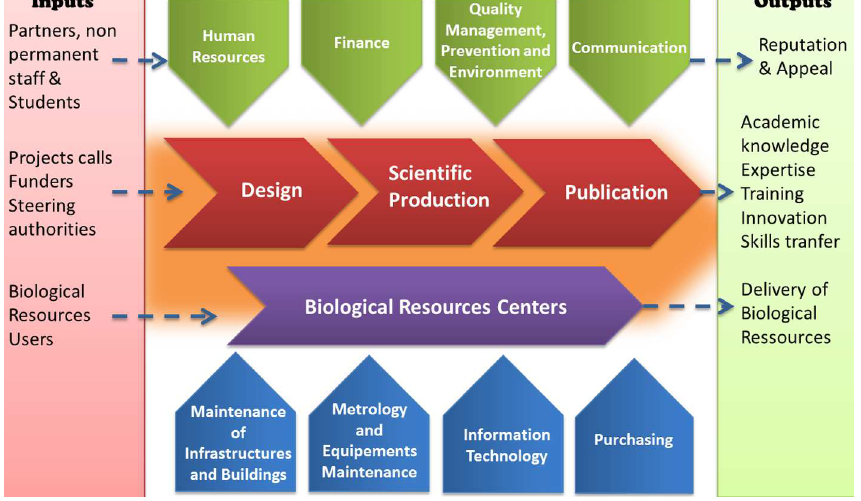
Fig. 3. Laboratory process mapping